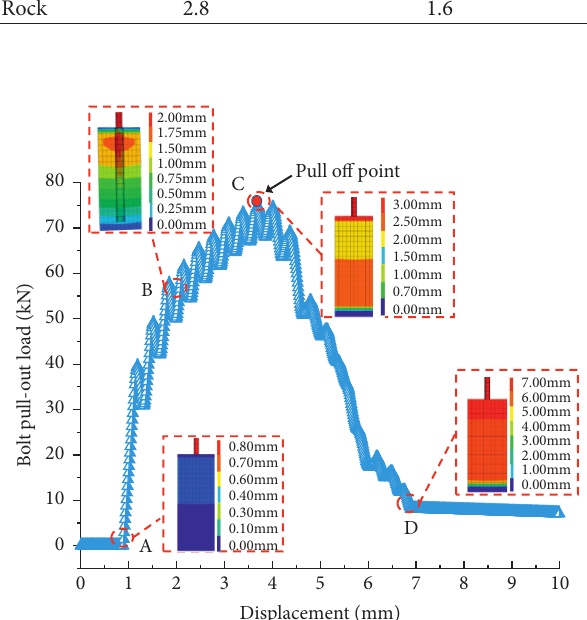
Figure 9: Loading and displacement curve of the bolt.